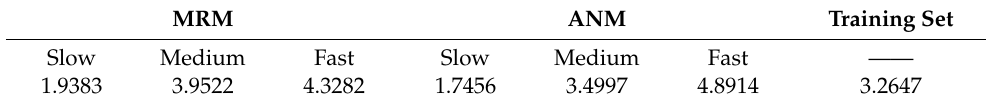
Table 5. Maximum velocities for each mode